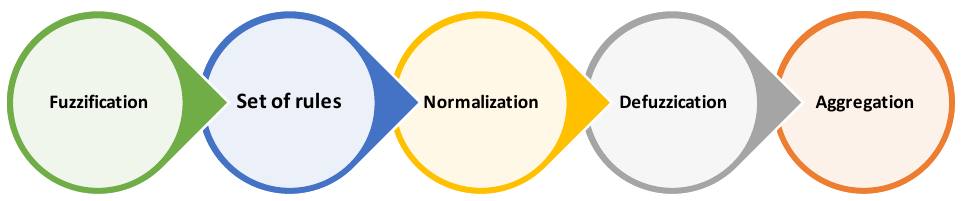
Figure 4. Illustration of adaptive neuro-fuzzy inference system (ANFIS) .